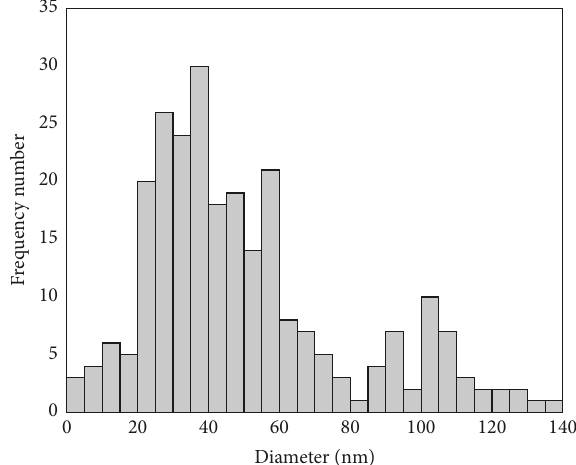
Figure 3: Histograms of the particles obtained at pH of 1.75, 15 ∘ C, 0.08 g of TW80, and 1g of